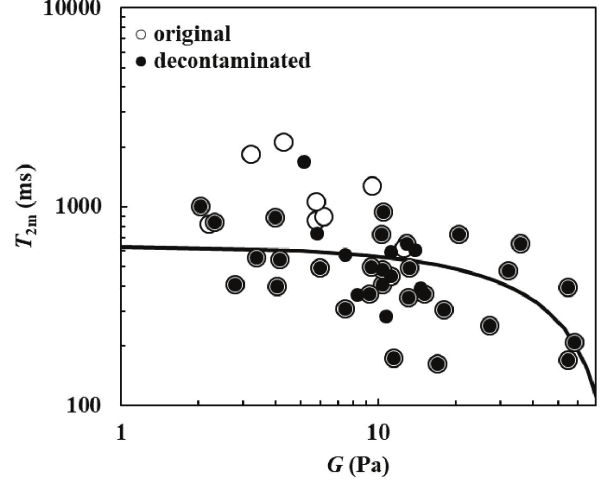
Fig. 9 – Correlation between the sputum average relaxation time (T ) and shear modulus G (38 samples). open circles re- 2m fer to T data not corrected for the possible saliva presence 2m (original) while closed circles represent corrected (decontami- nated) T data. Solid line is the linear interpolant evaluated on 2m corrected